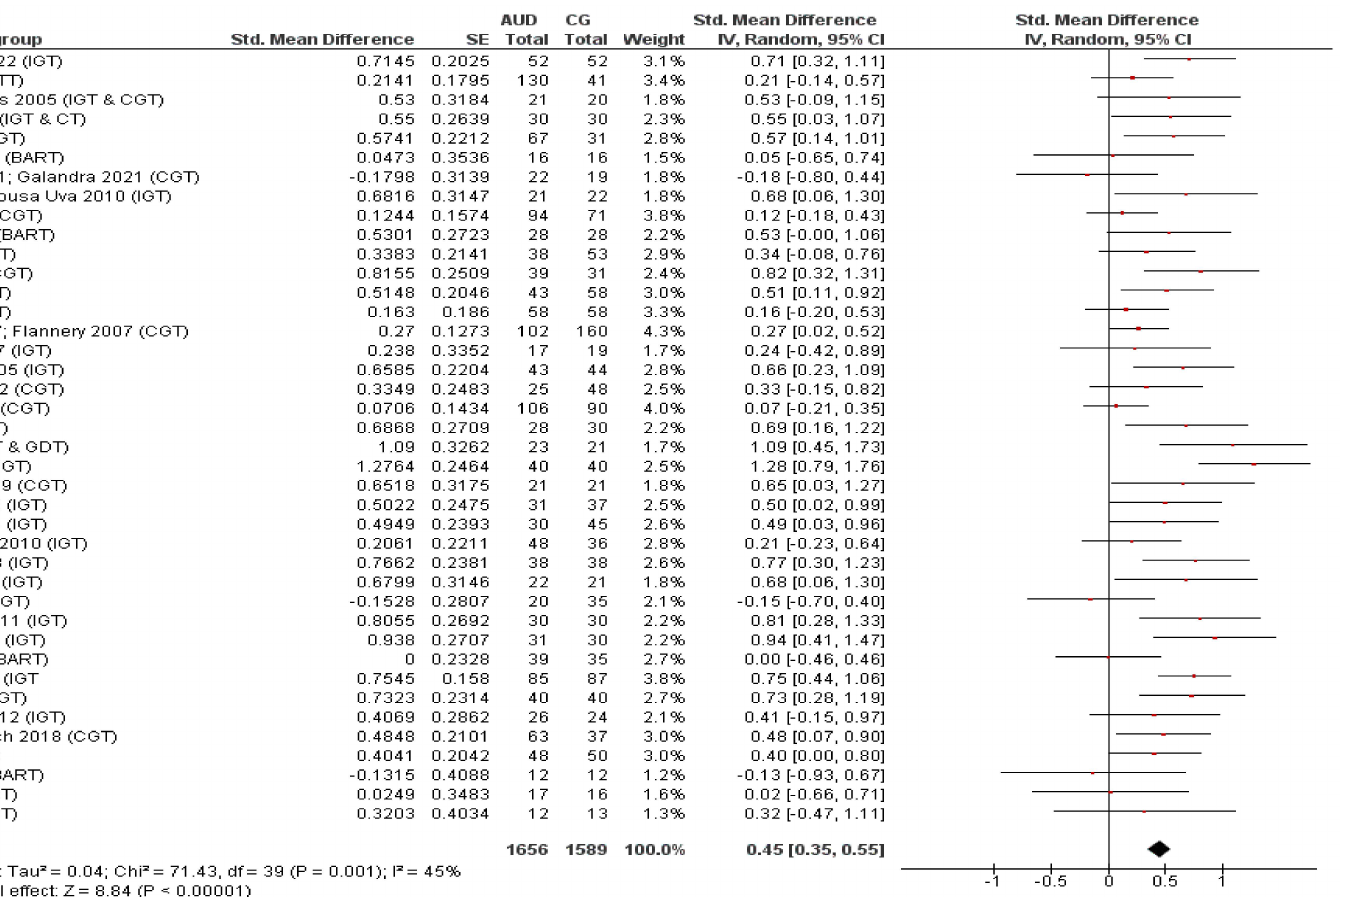
Figure 2. Forest plot of studies assessing the level of risk taking of adults with AUD compared to control participants included in the global meta-analysis. Note: The black diamond represents the pooled result of the studies included in the global meta-analysis (pooled Hedges’ g = 0.45, 95% CI = 0.35–0.55). Abbreviations (in alphabetical order): AUD = alcohol use disorder (group). BART = Balloon Analogue Risk Task. CG = control group (without (severe) psychiatric and/or neurological disorders). CGT = Cambridge Gambling Task. CI = confidence interval. CT = Cups Task. df = degrees of freedom. GDT = Game of Dice Task. IGT = Iowa Gambling Task. IV = weighted mean difference. P = probability value. RTT = Risk Taking Task. SE = Standard Error. Std. Mean Difference = Standardized Mean